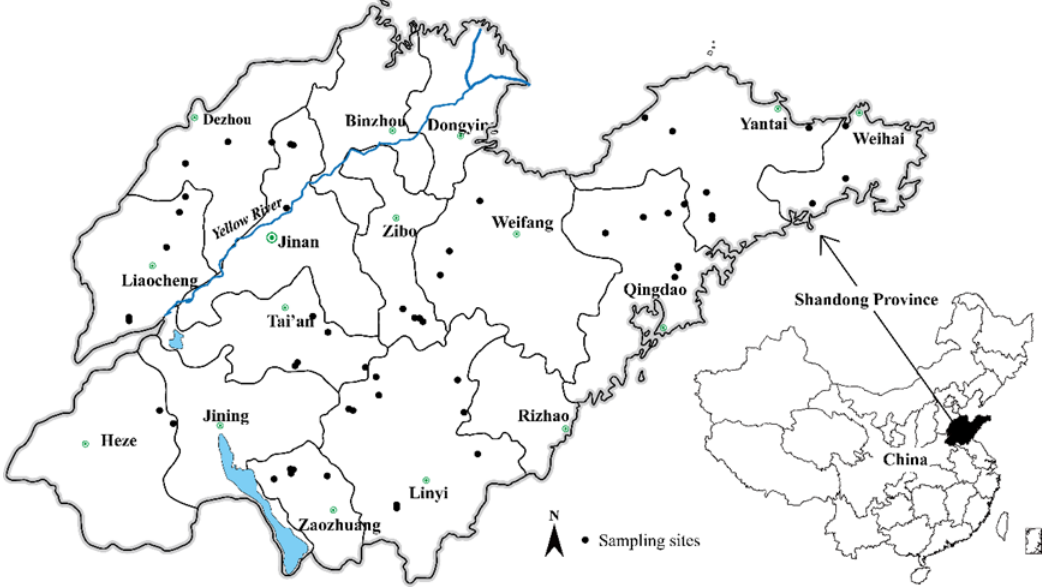
Figure 1. The location of sampling sites in the twelve cities of Shandong Province.